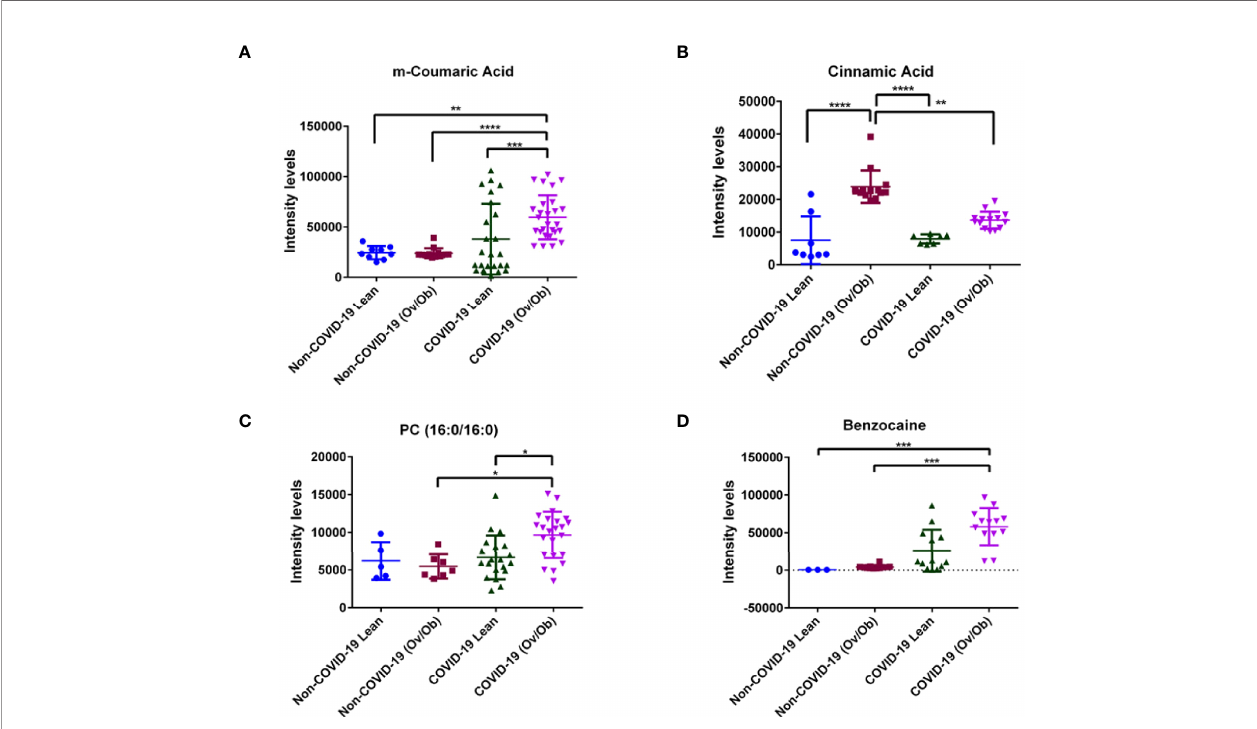
FIGURE 2 | Alteration in plasma metabolite levels of COVID-19 lean and obese patients compared to non-COVID-19 lean and obese patients. Plasma levels of different metabolites (A) m-Coumaric acid (B) Cinnamic acid (C) Phosphatidylcholine [PC (16:0/16:0)] and (D) Benzocaine, were signi fi cantly different in COVID-19 lean and overweight-obese patients when compared to controls (non-COVID-19). Analysis was performed using one-way ANOVA with Dunn ’ s multiple comparison and Kruskal-Walis tests; * P < 0.05; ** P < 0.01; *** P < 0.001; **** P < 0.0001. The y axis in the dot plots indicates arbitrary units of median